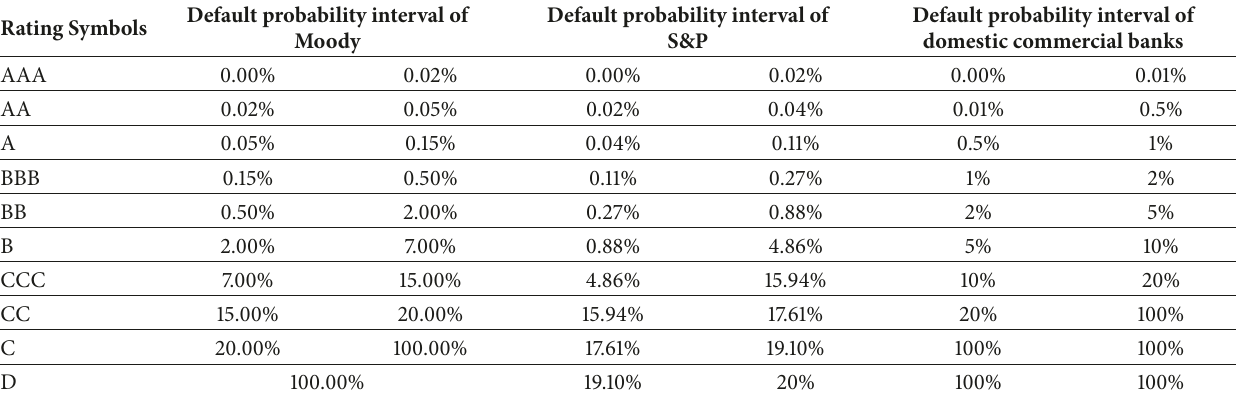
Table 1: Credit ratings with the corresponding default probability of Moody, S&P, and domestic commercial banks. Rating